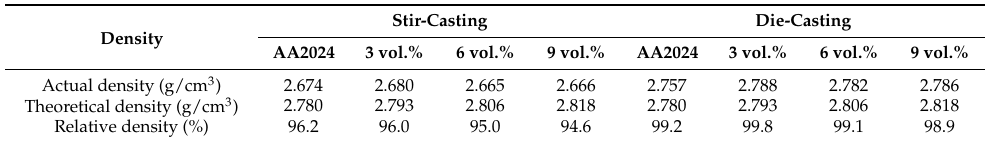
Table 2. Density of AA2024 and aluminium matrix composites (AMCs) in stir-casting (SC) and die-casting (DC) processes.